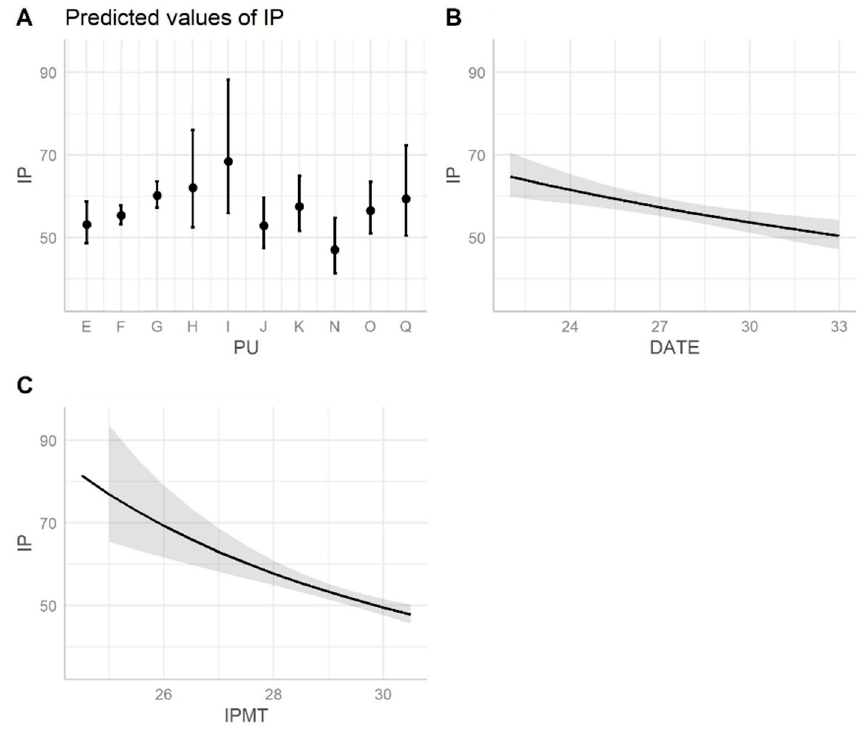
Figure 6. Predicted values of IP (estimated marginal means) of loggerhead turtle nests in Sicily plotted separately to show the effect of each IV, originated from the fittest GLM model. Dots in plot ( A ) show the predicted value for each PU, whiskers represent 95% CI. Plot ( B , C ) represent regression lines based on the GLM model with 95% CI in light gray. DATE: date of nesting (week of the year). IPMT: mean air temperature during the incubation period (°C).